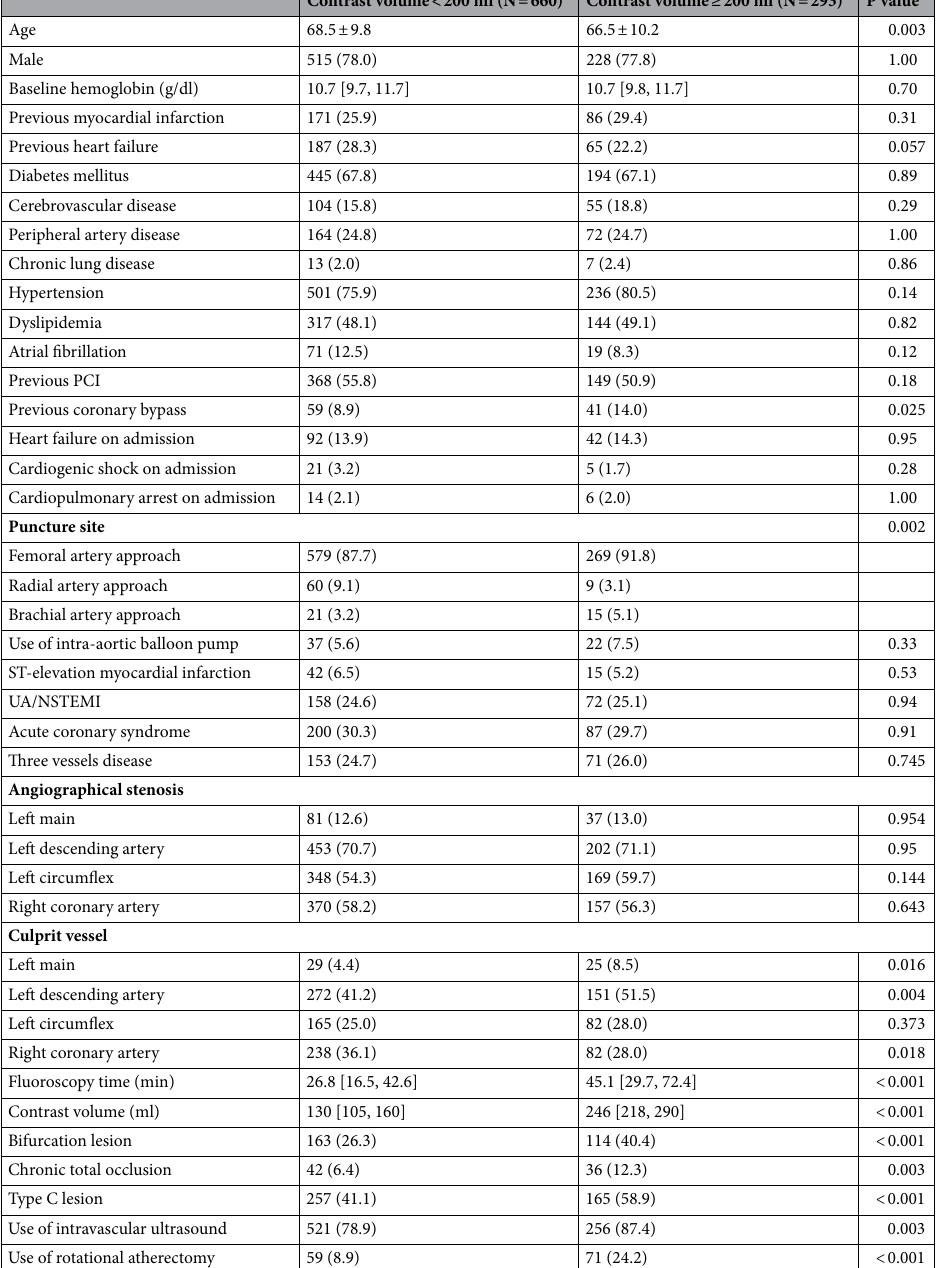
Table 1. Baseline characteristics of all patients; contrast volume < 200 ml versus contrast volume ≥ 200 ml. PCI, percutaneous coronary intervention; UA/NSTEMI, unstable angina/non-ST-elevation myocardial infarction. Data are presented as the mean ± standard deviation, number (%), and number [interquartile